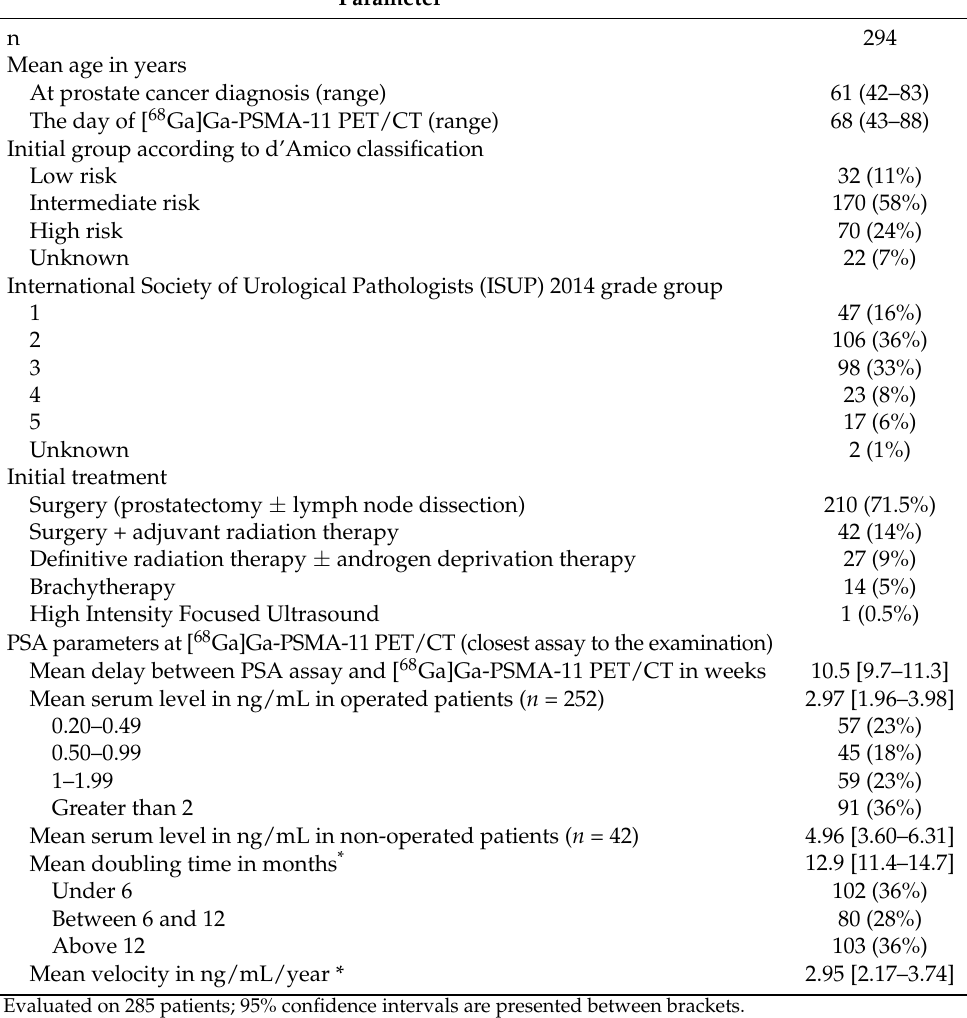
Table 1. Patient